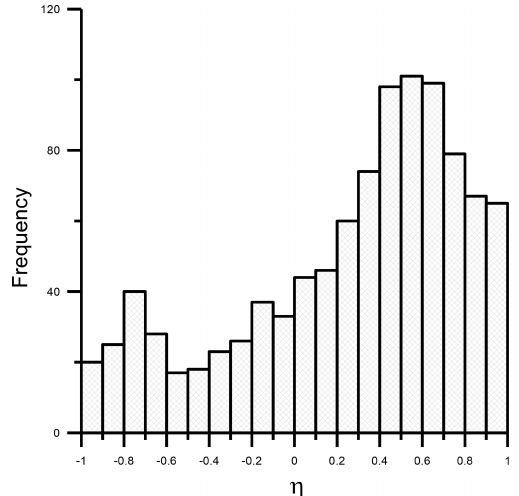
Figure 8. Histogram of the ratio η = (w Gaussian − w Gumbel )/ (w Gaussian + w Gumbel ) , which measures the distance to the critical